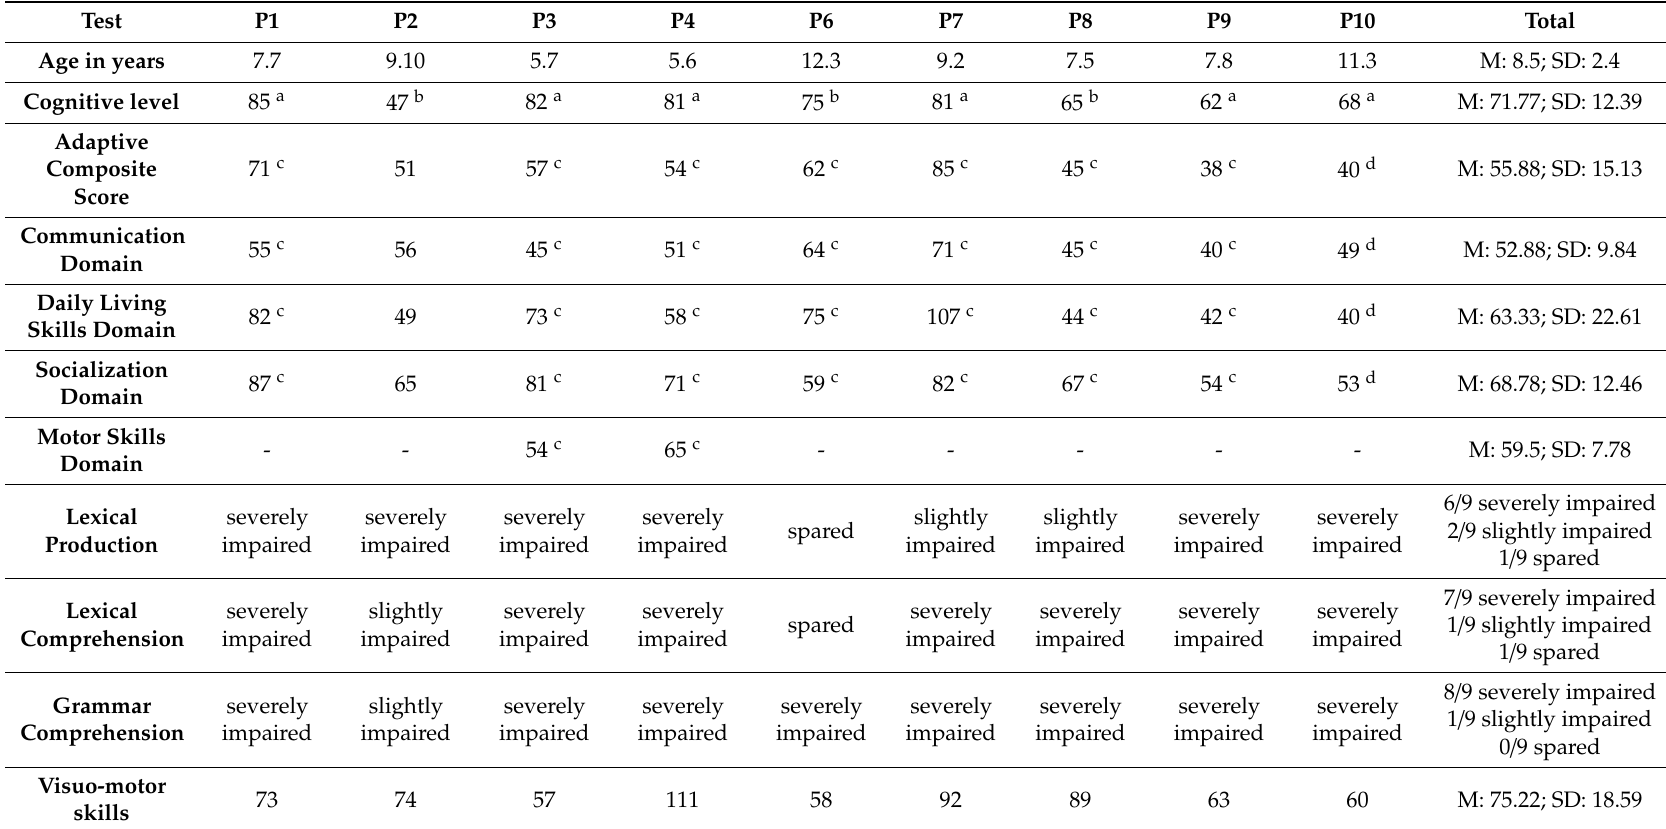
Table 2. Cognitive, adaptive, language and visuo-motor